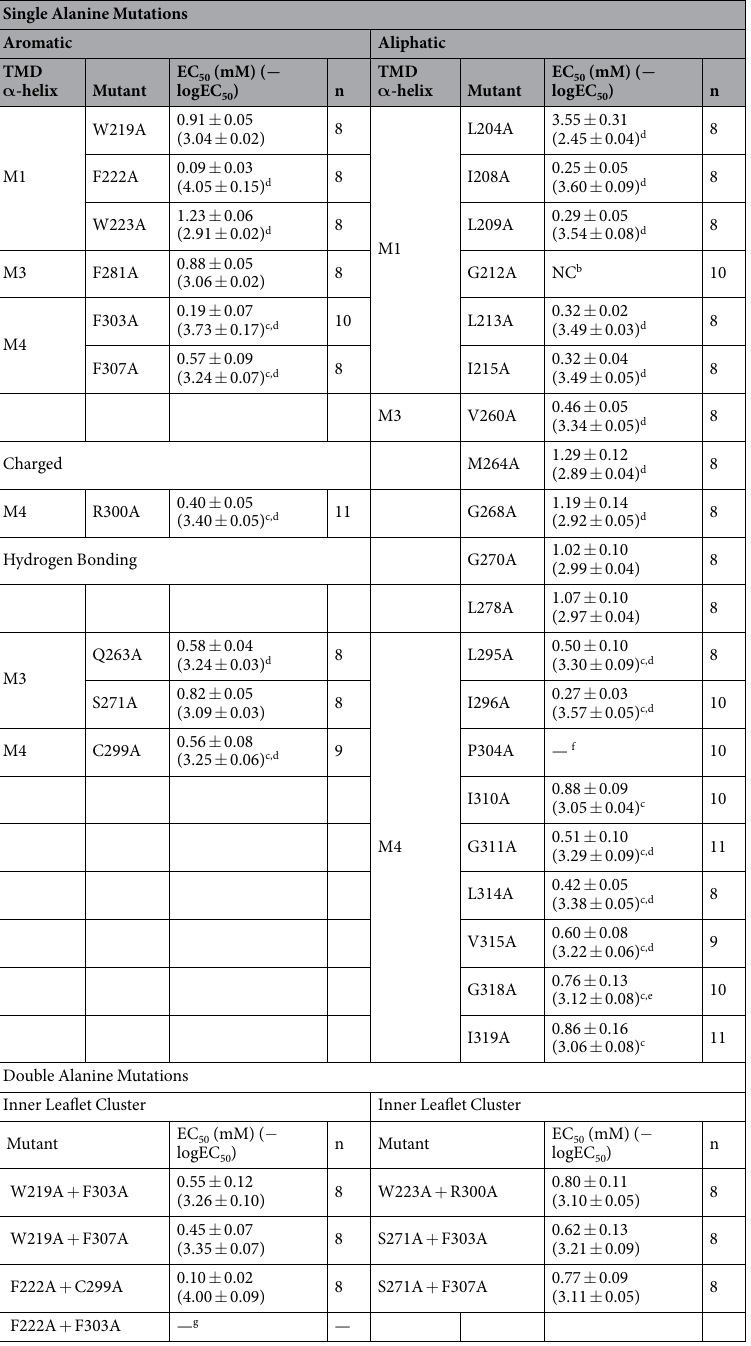
— g — Table 2. The Functional Effects of Alanine Mutations of Residues located at the M4-M1/M3 Interface of ELIC. a Data collected 1–4 day(s) after cRNA injection (V − 20 to − 40 mV). Error Values represent Hold ranging from the standard deviation. b No current (NC) observed in oocytes after 1–4 day(s) of cRNA injection. c Data taken from Henault et al . 9, 18, 29 . d p < 0.001 relative to the − Log[EC 50 ] of WT ELIC via one-way ANOVA followed by Dunnet’s post hoc test. e p < 0.05 relative to the − Log[EC 50 ] of WT ELIC via one-way ANOVA followed by Dunnet’s post hoc test. f Functionally distinct, EC 50 Values were not obtained. g Injected oocytes gave weak response to cysteamine and died past day